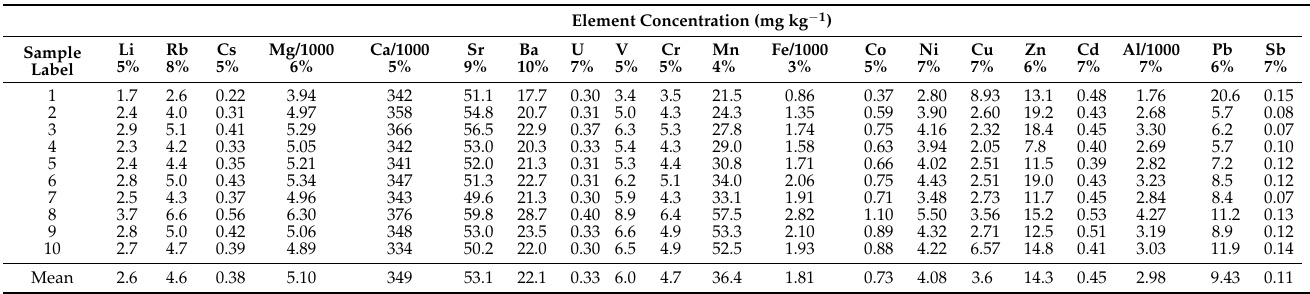
Table A1. Element concentrations (mg kg − 1 ), with relative uncertainties of measurement (%) in tufa samples. The elements are arranged following the periodic table